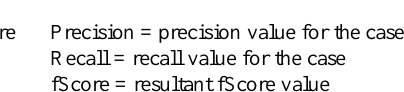
Figure 7. Vegetation change image between 2006 and 2016